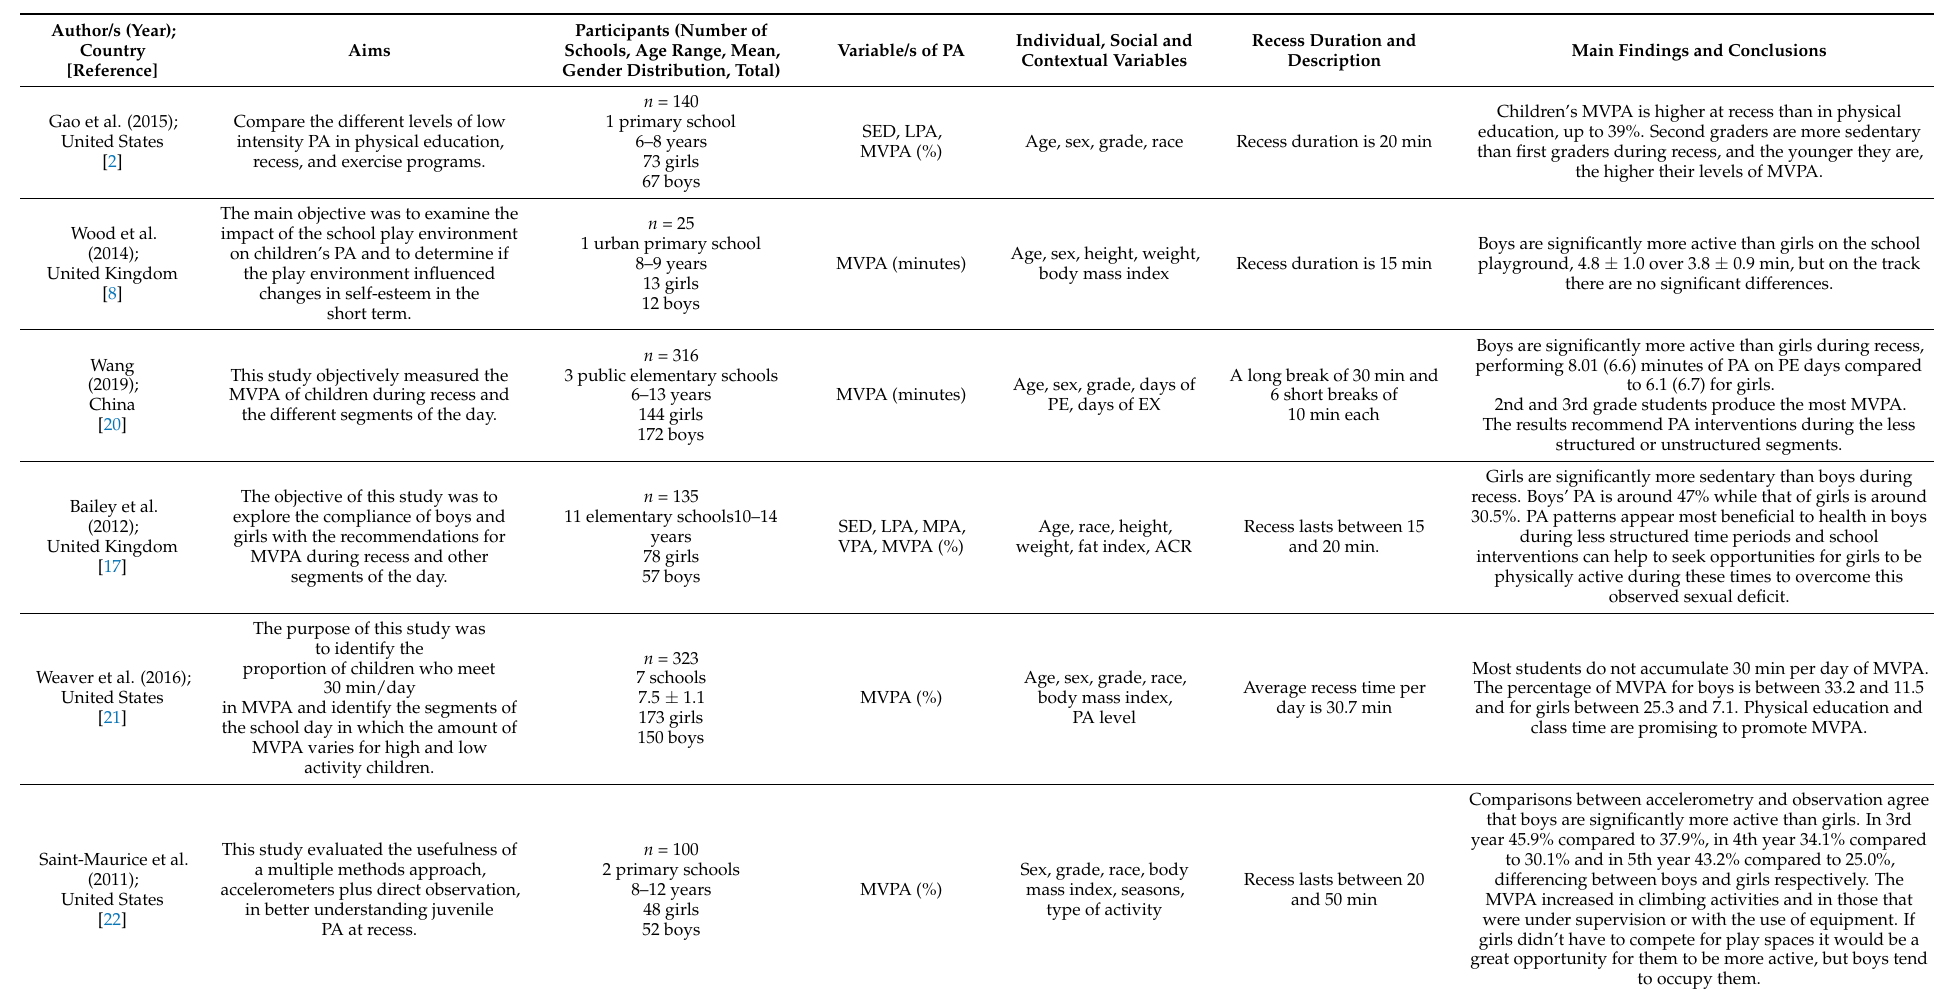
Table 3. Main characteristics of cross-sectional